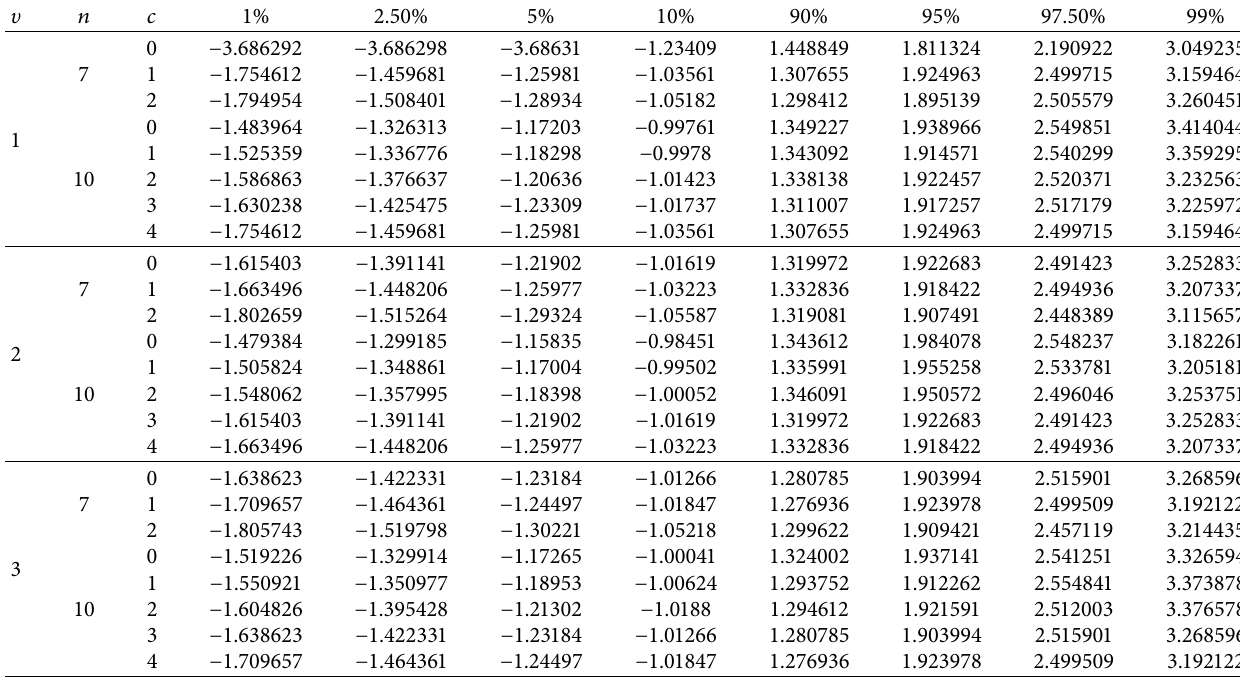
when μ � 0 and σ � 1. 1